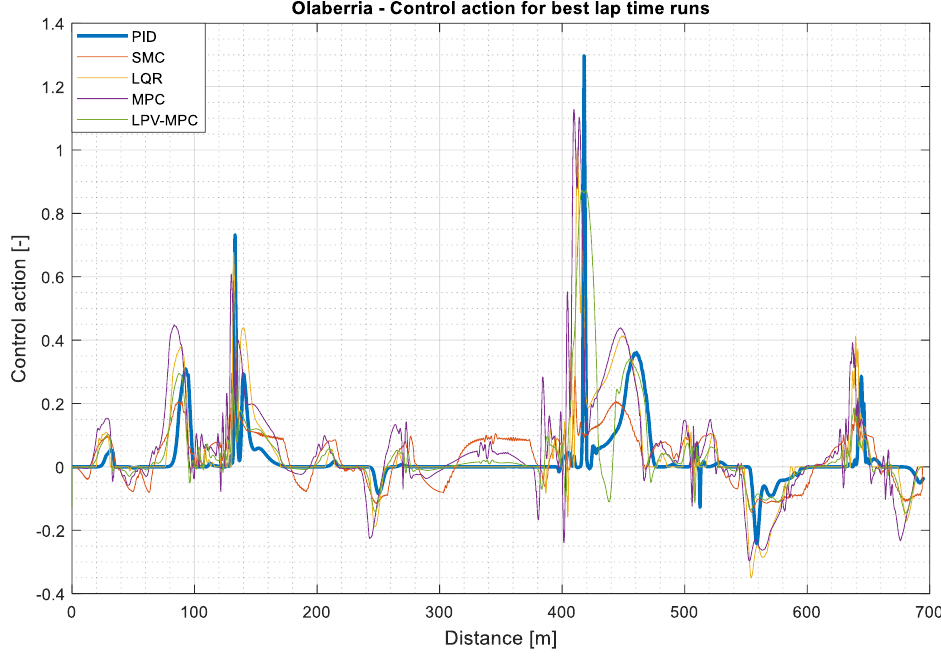
Figure 11. Control action of each controller for best lap time runs.